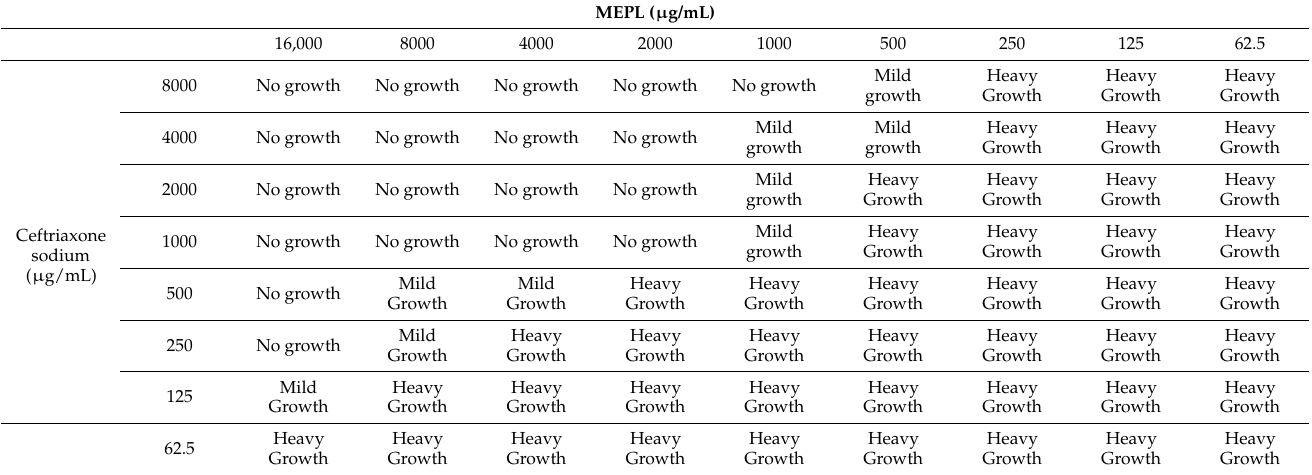
Table 2. Synergistic effect of MEPL and ceftriaxone sodium was determined by the checkerboard